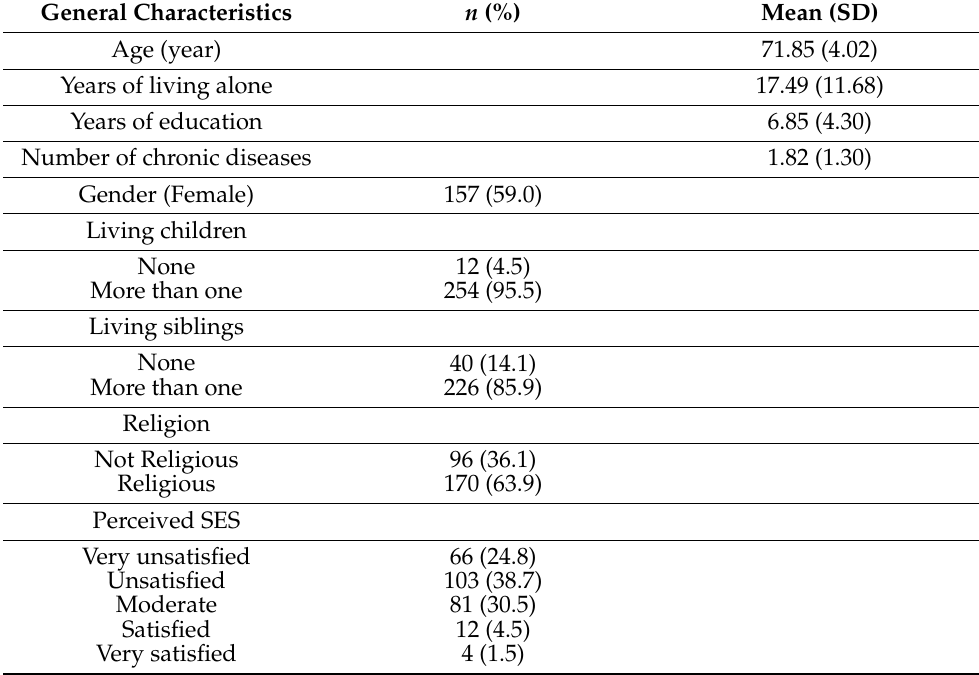
Table 1. General characteristics of participants and descriptive statistics ( n = 266). General